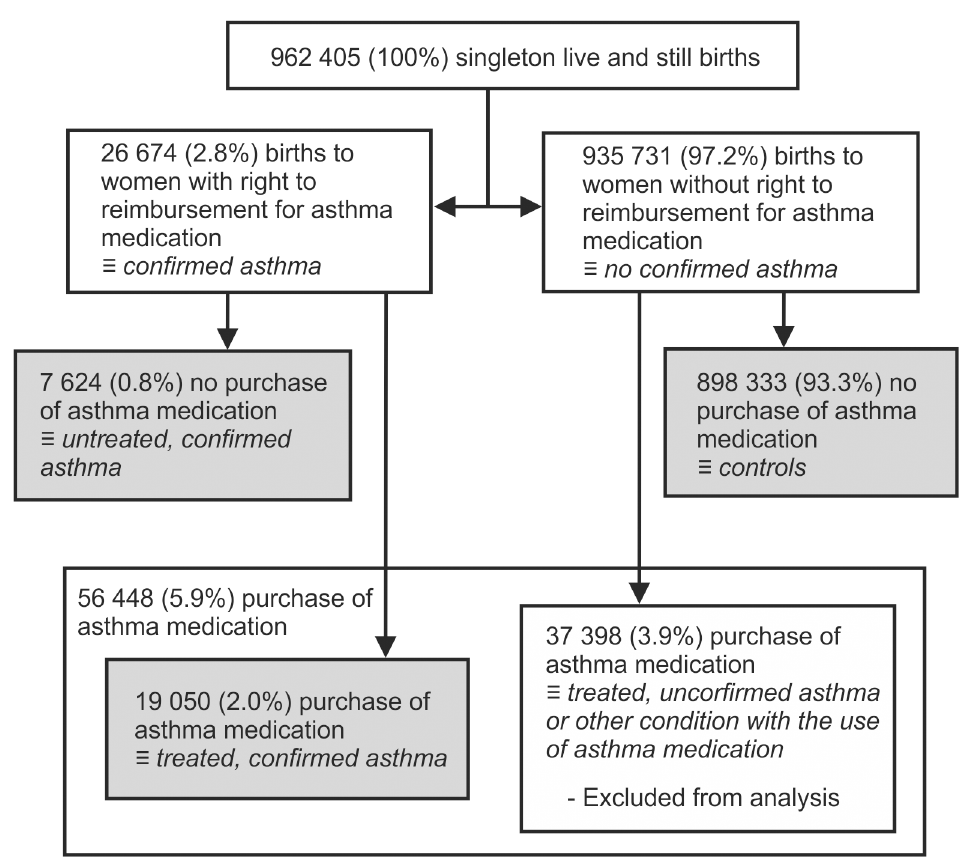
Fig 1. Demographics of the 962 405 singleton live and stillbirths between 1996 and 2012. The separation into different